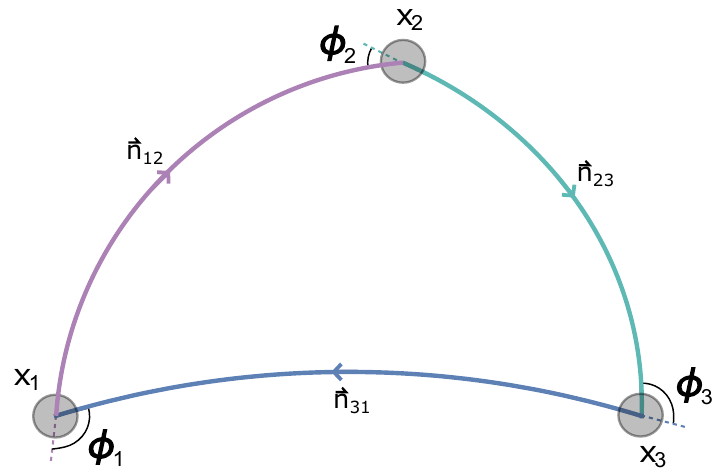
Figure 1 . The Maldacena-Wilson loop with three cusps. The cusps are connected by circular arcs with 3 di(cid:11)erent scalars ~ (cid:8) (cid:1) ~n ij coupled to the three di(cid:11)erent arcs. The expectation value of this object behaves exactly in the same way as a three point correlation function of 3 local operators but provides additional 6 parameters (2 for each cusp) (cid:30) 1 ; (cid:30) 2 ; (cid:30) 3 and cos (cid:18) 1 = ~n 12 (cid:1) ~n 23 ; cos (cid:18) 2